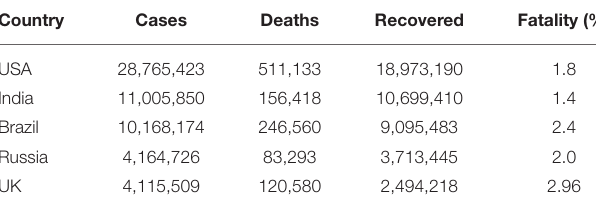
TABLE 1 | Top 5 affected countries COVID-19 data. Country